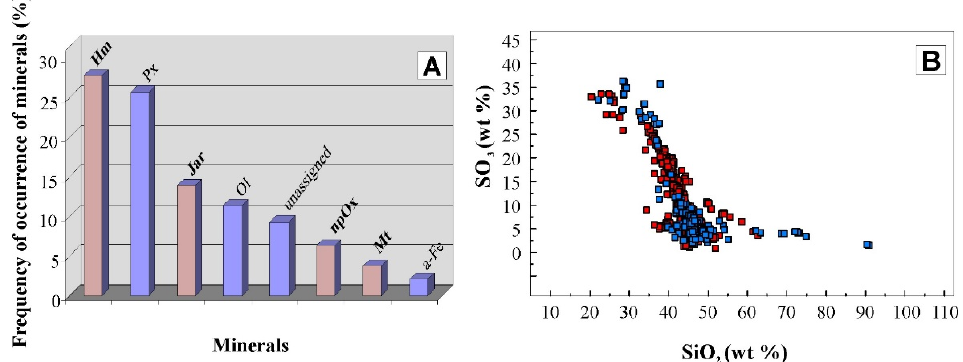
Figure 8. Mineralogical features and S abundance of the Martian analyzed soils. ( A ) Bar chart of the main analyzed iron minerals (Mossbauer data by Opportunity rover, MER Data Sets Online at Geosciences at link: https://pds-geosciences.wustl.edu/missions/mer/geo_mer_datasets.htm accessed on 9 January 2019) Hm = hematite, Px = pyroxene, Jar = jarosite, Ol = olivine, npOx = iron oxide nanoparticles, Mt = magnetite, a-Fe = alpha iron. ( B ) SiO 2 vs. SO 3 variation diagram based on bulk chemical data (APXS) from the NASA database detected for Martian soils by NASA’s Mars Exploration Spirit rover (blue squares) and Opportunity rover (red squares), (MER Data Sets Online at Geosciences at link: https://pds-geosciences.wustl.edu/missions/msl/apxs.htm accessed on 9 January 2019).